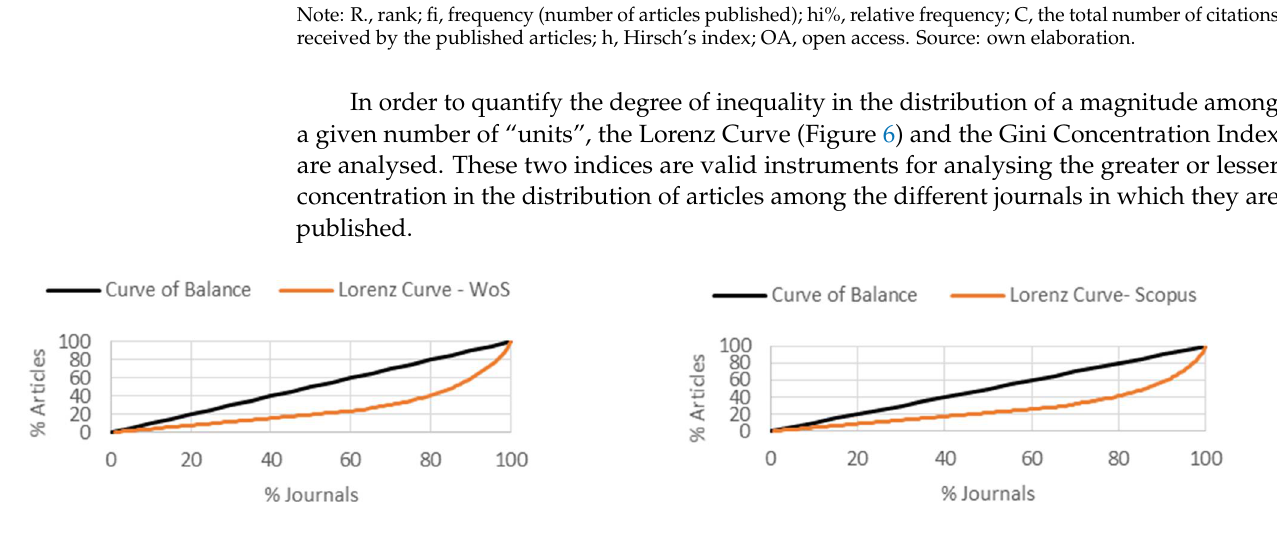
Figure 6. Lorenz curves (distribution of number of articles in journals in which they are published). Regarding the Gini index, its value is between 0 and 1, with zero being the maximum equality (all journals publish the same number of articles) and 1 the maximum inequality (all articles belong to a single